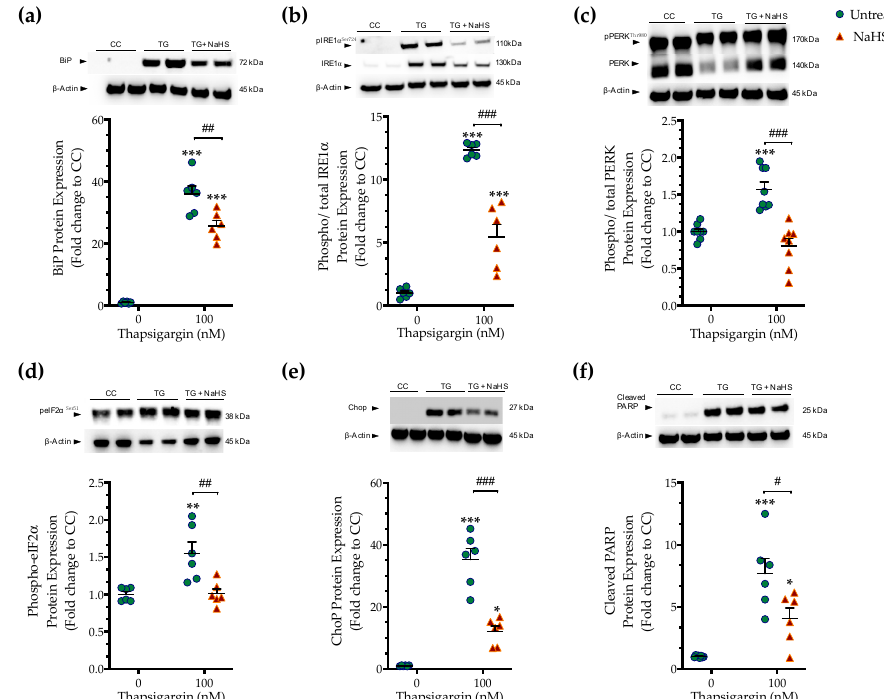
Figure 3. NaHS co-treatment ameliorates the hepatic unfolded protein response (UPR). HepG2 cells were serum-starved for 8 h and treated with the vehicle or 100 nM of thapsigargin (TG), in the presence or absence of 100 µM NaHS for 16 h. Cells were harvested and the extracted protein was processed for Western blotting analysis of the expression levels of BiP ( a ), activating phosphorylation of IRE1 α at the serine residue 724 (Ser724) ( b ), the activating phosphorylation of PERK at the threonine residue 980 (Thr980) ( c ), the inhibitory phosphorylation of eIF2 α at Ser51 ( d ), Chop ( e ), and of cleaved PARP ( f ). Each graph line represents mean ± SEM from three independent experiments. Data are expressed as a fold change of the control (vehicle-treated) conditions (CC). * p ≤ 0.05, ** p ≤ 0.01; *** p ≤ 0.001 compared to CC; # p ≤ 0.05, ## p ≤ 0.01, ### p ≤ 0.001 compared to TG-treated HepG2 cells. For the abbreviations used, please refer to the main